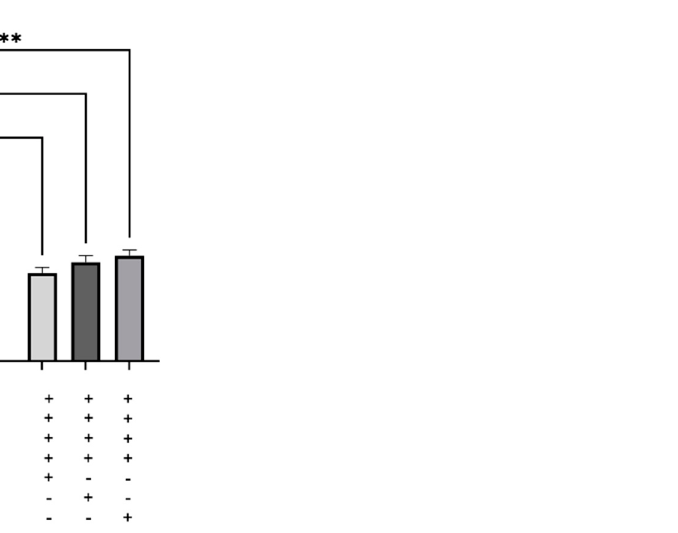
Figure 7. Adenosine deaminase inhibition together with adenine and ribose supplementation provided benefit for endothelial cell function in CoCl 2 -mimicked hypoxia by A1 adenosine receptor mediated mechanism. The concentration of total NO in the HMEC-1 cell culture media after 24 h of CoCl 2 -mimicked hypoxia in the presence of adenine (Ade), ribose (Rib), 2 ′ deoxycoformycin (dCF, adenosine deaminase inhibitor), DPSPX (A1R antagonist), istradefylline (Istra, A2aR antagonist) and PSB1115 (A2bR antagonist). Results are shown as mean ± SEM; n = 6; * p < 0.05, ** p < 0.01; ns = not significant.